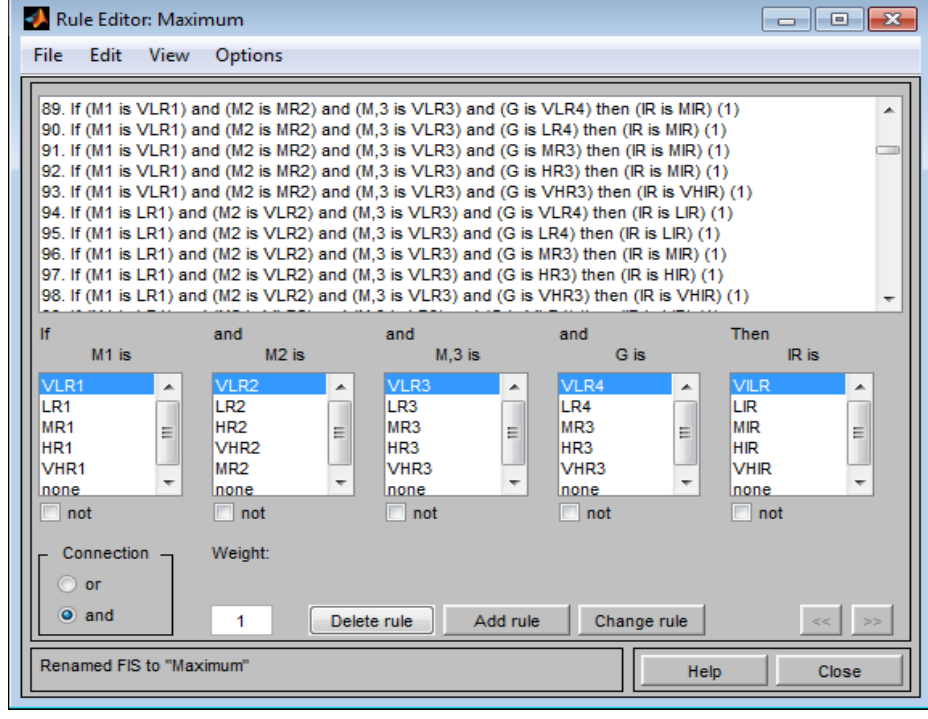
Figure 14. M RB method rules in the rules-based top-level fuzzy logic.